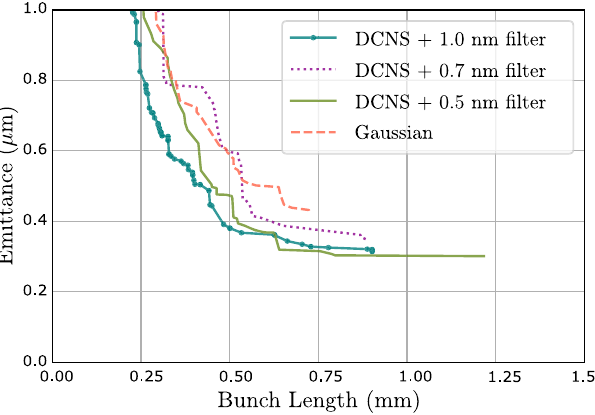
FIG. 4. Pareto front comparison of DCNS and Gaussian performance for the LCLS-II injector. DCNS pulses in combi- nation with a 1.0 nm spectral filter, achieves the lowest emittance values at most bunch lengths. The lowest achieved emittance value is 0 . 30 μ m at a bunch length of 1.22 mm, using a 0.5 nm